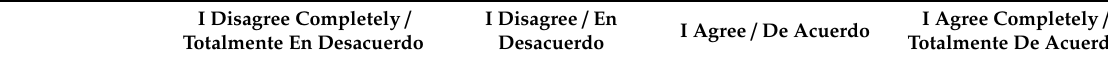
Table A1. HIV Attitudes Scale for Adolescents–Colombian